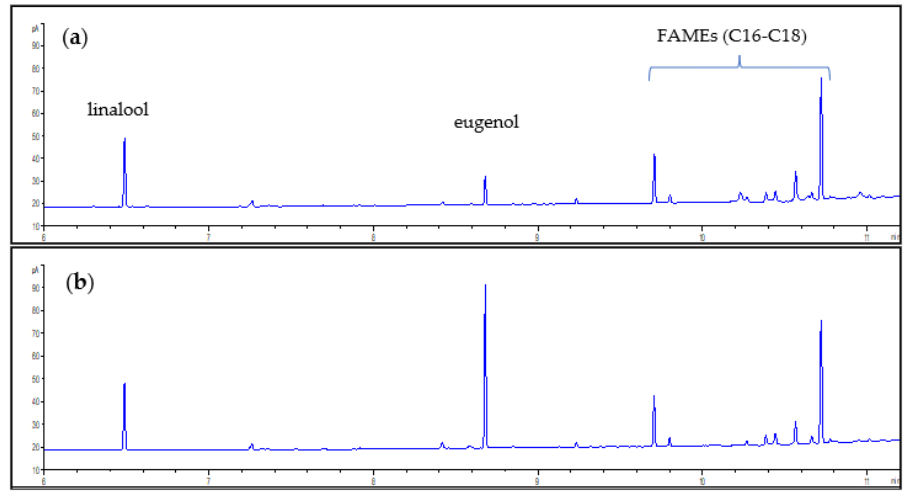
Figure 2. ( a ) Chromatogram obtained quenching the transmethylation reaction with water; ( b ) Chromatogram obtained by quenching the transmethylation reaction with acidic solution. Table 2. Compounds detected by the GC-MS analysis of a transmethylated basil leaves extract